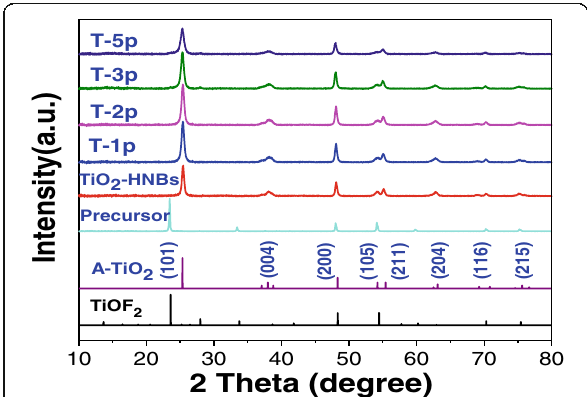
Fig. 4 XRD patterns of as-prepared